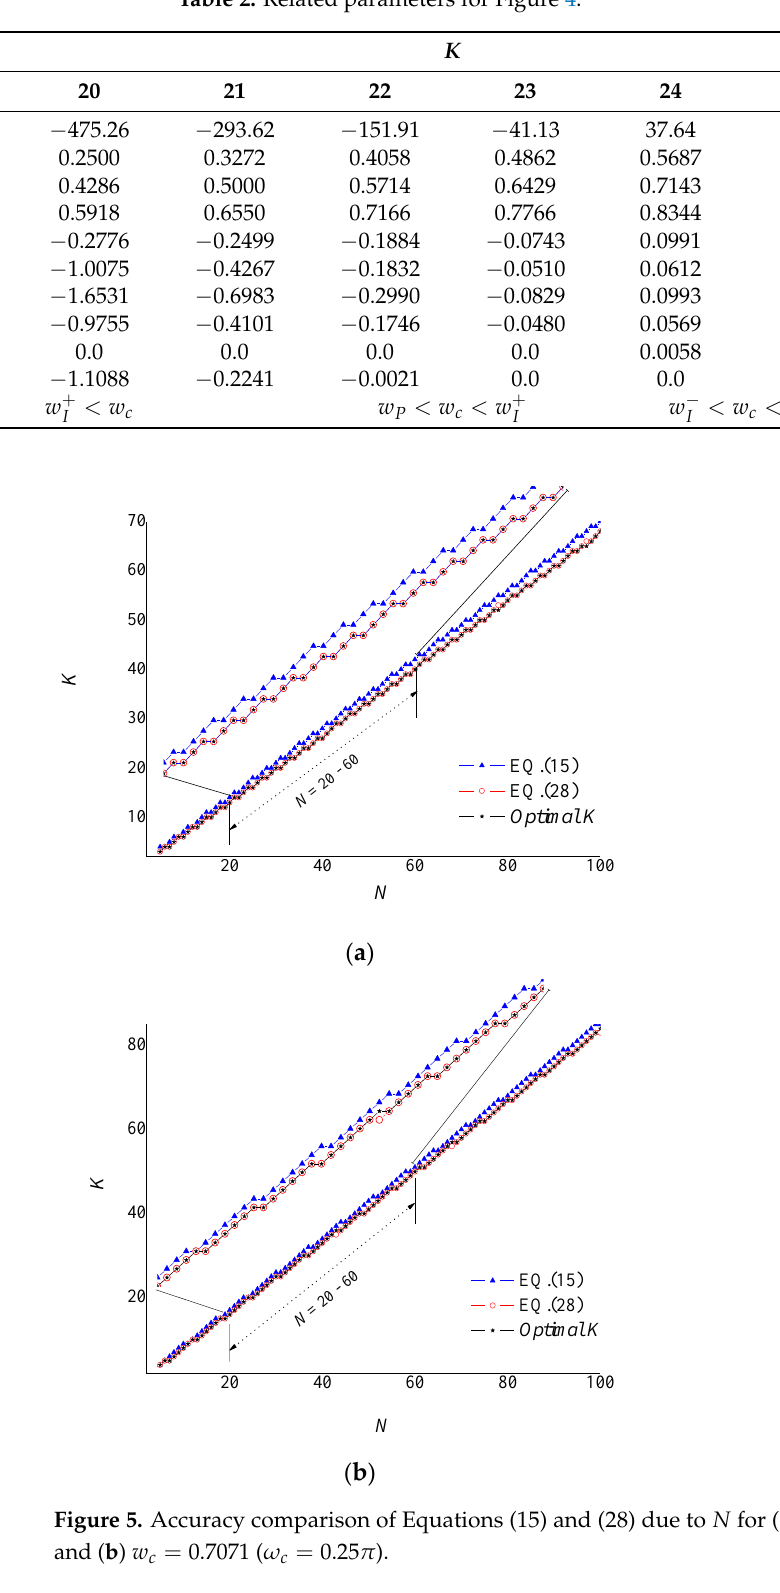
Figure 6. Design procedure of cut off-frequency fixing filters.